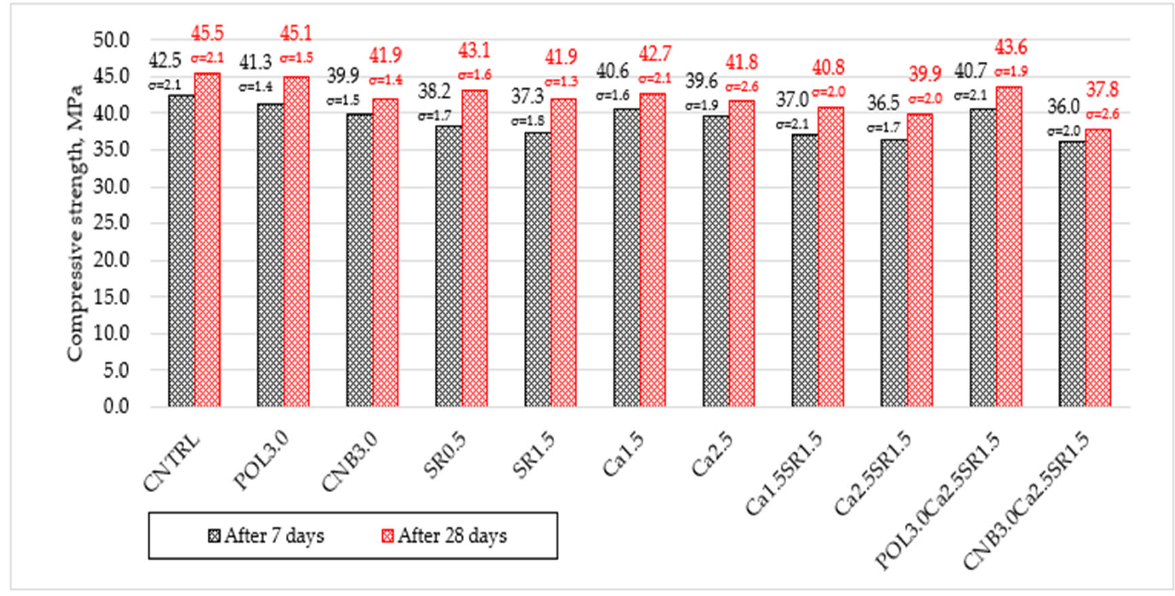
Figure 4. The compressive strength of concrete after 7 and 28 days.